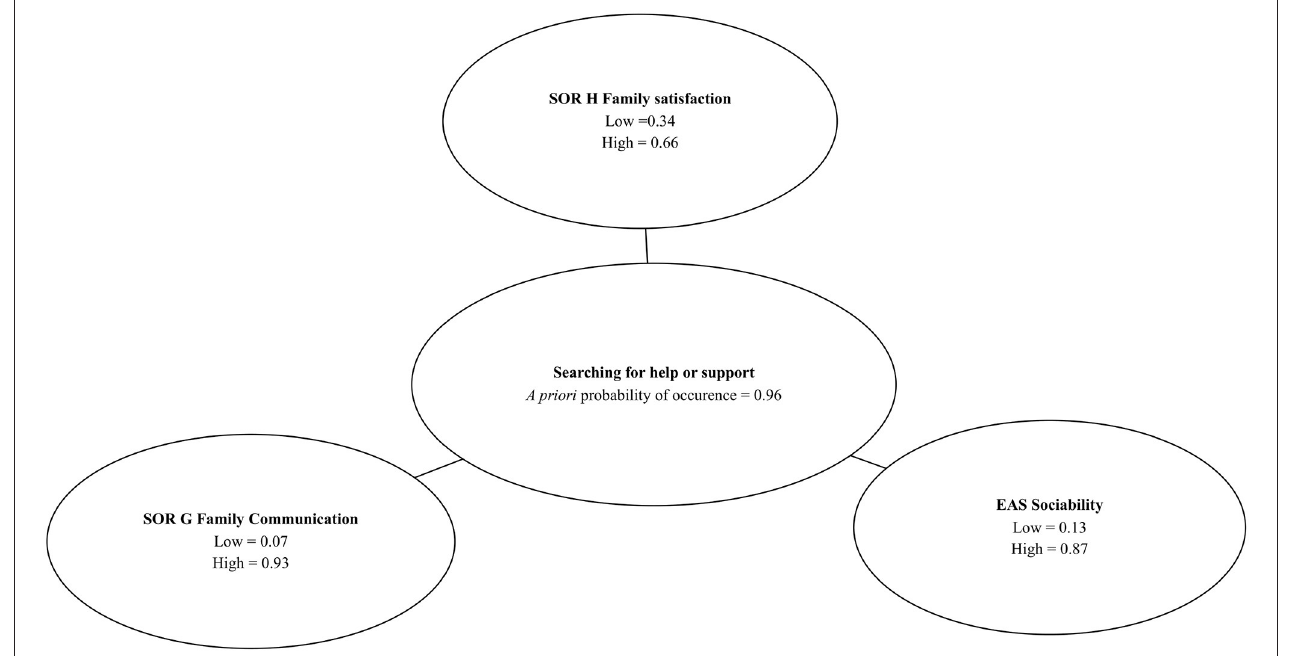
FIGURE 4 | A priori probability of searching for help or support and distribution of values of the predictor